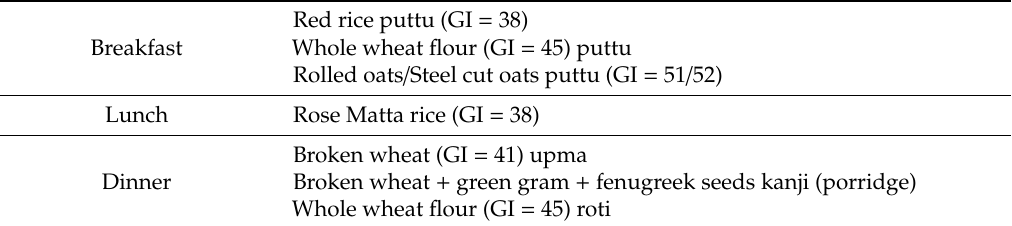
Table 1. The diet plan for the low glycemic index (LGI) diet